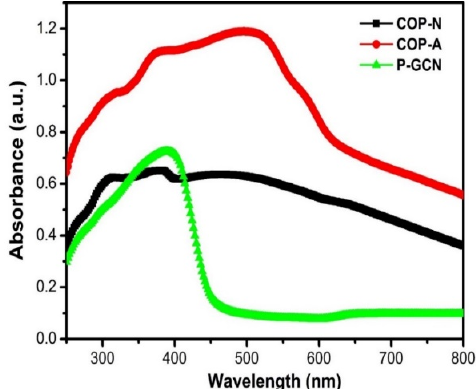
Figure 8. UV-visible spectra of COP-N, COP-A, and P-GCN.